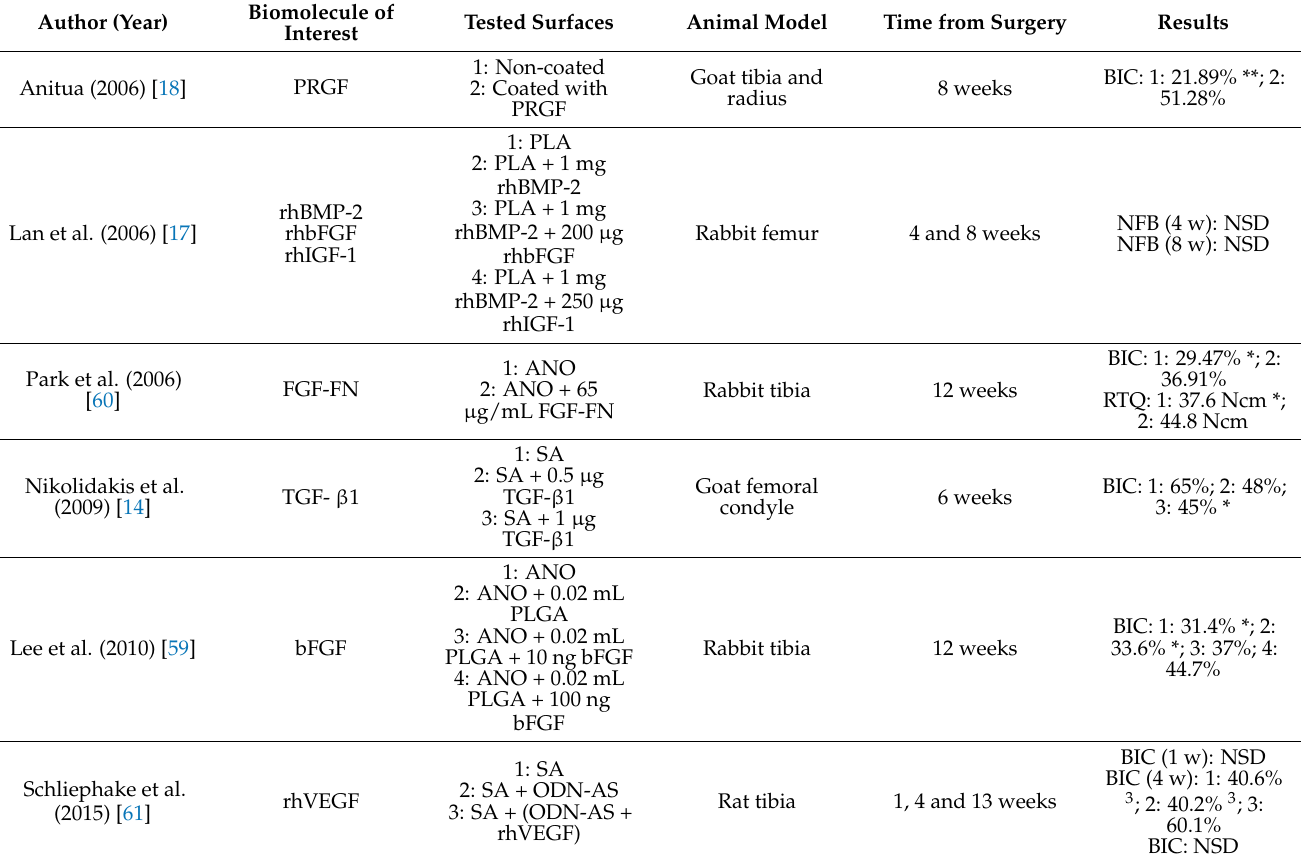
Table 4. Non-BMPs growth factors: results from the considered